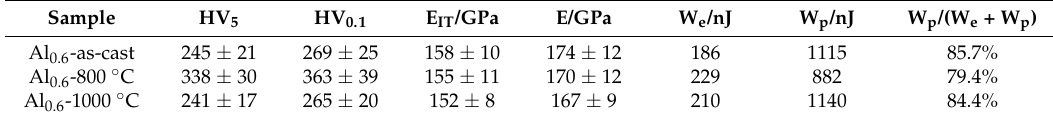
Table 2. Properties of Al 0.6 high-entropy alloys.